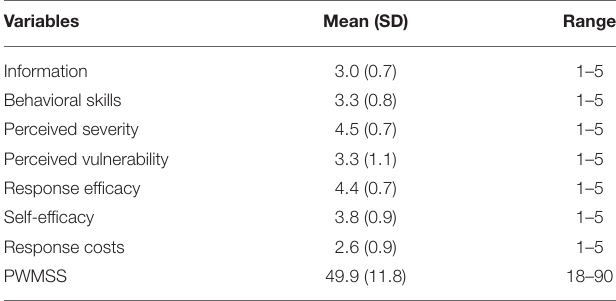
TABLE 2 | Mean, standard deviation (SD), and range of scores for the constructs of the PMT-IMB model and PWMSS ( n =